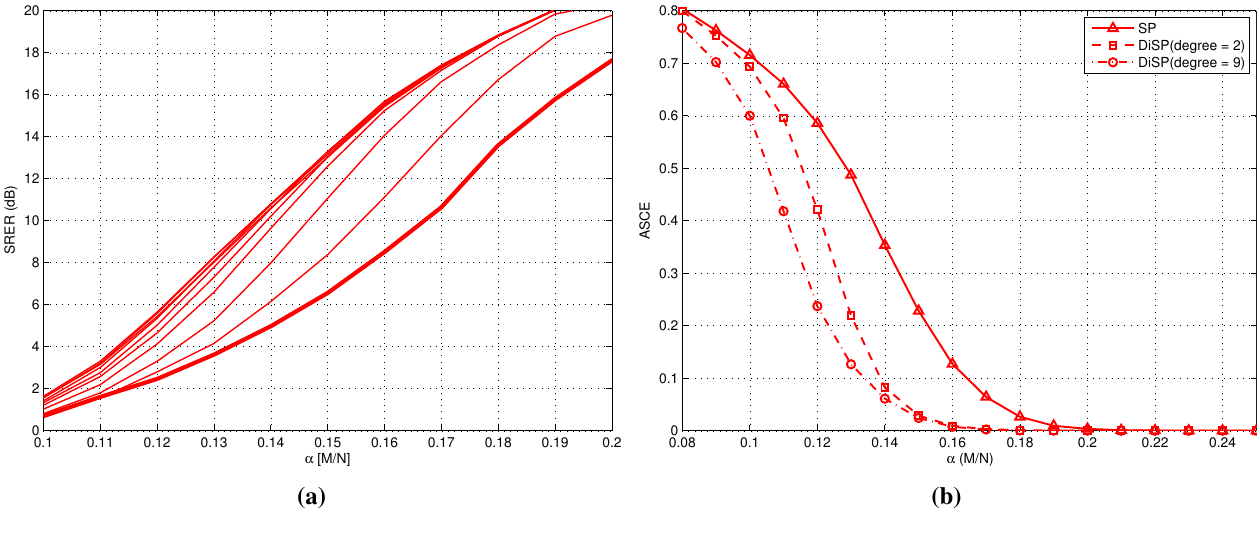
Figure 6. SRER vs . ρ